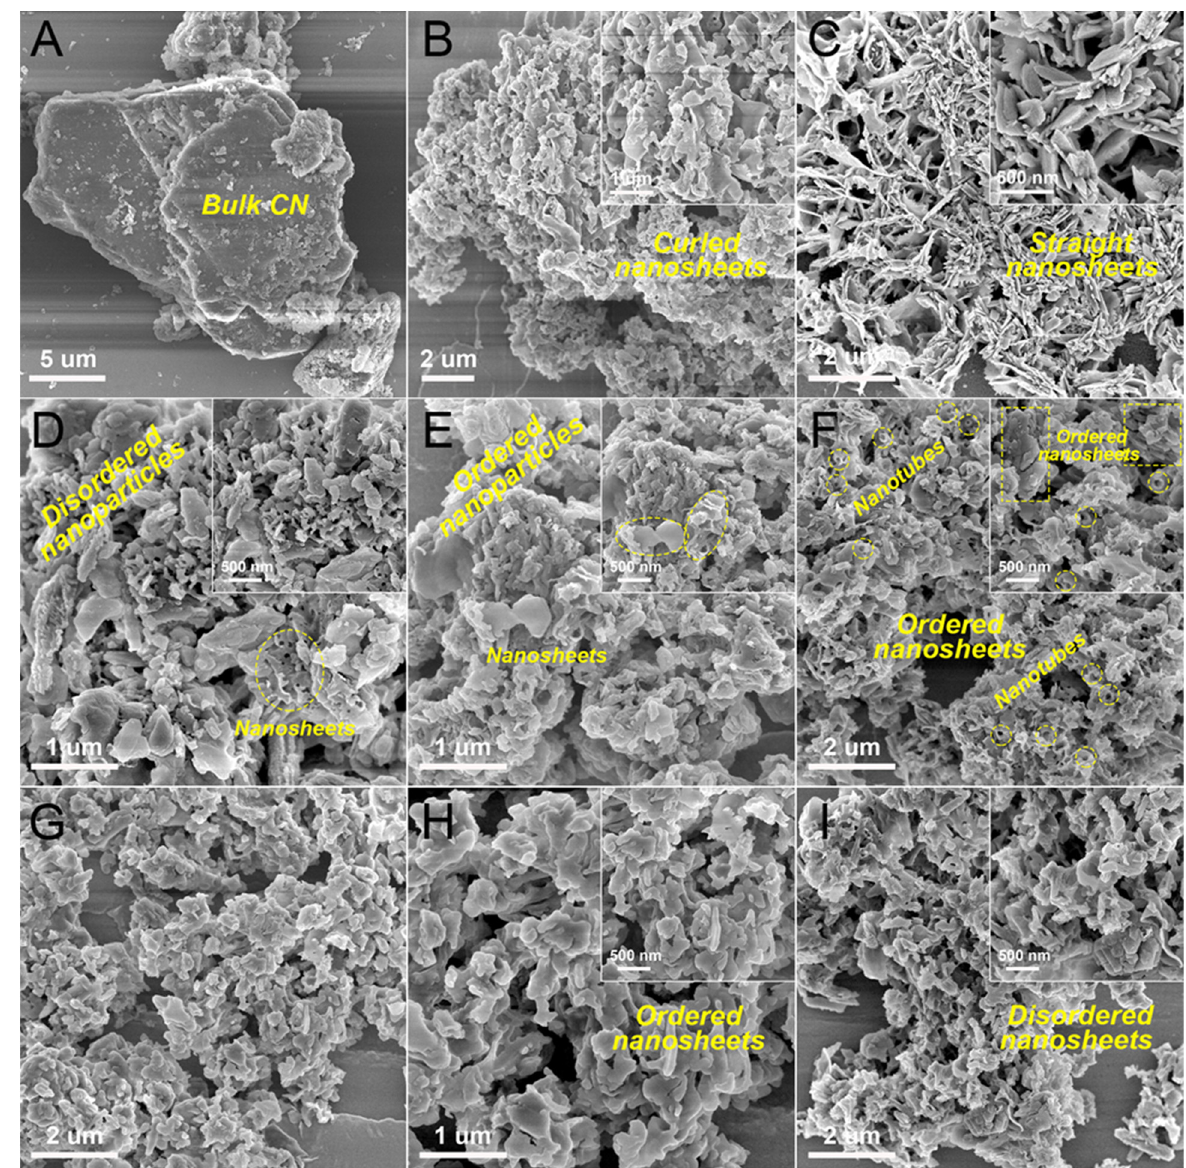
Figure 3. SEM images of ( A ) m-CN, ( B ) u-CN, ( C ) mu-CN, ( D ) m-CN/SiNSs, ( E ) mu-CN/SiNSs-1, ( F ) mu-CN/SiNSs-2, ( G , H ) mu-CN/SiNSs-3, and ( I )